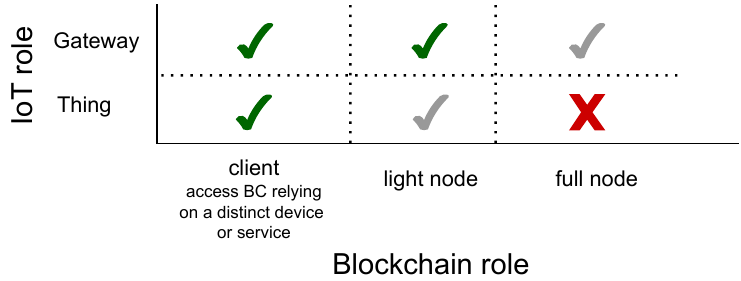
Figure 3. Summary of the possible blockchain roles that IoT devices can